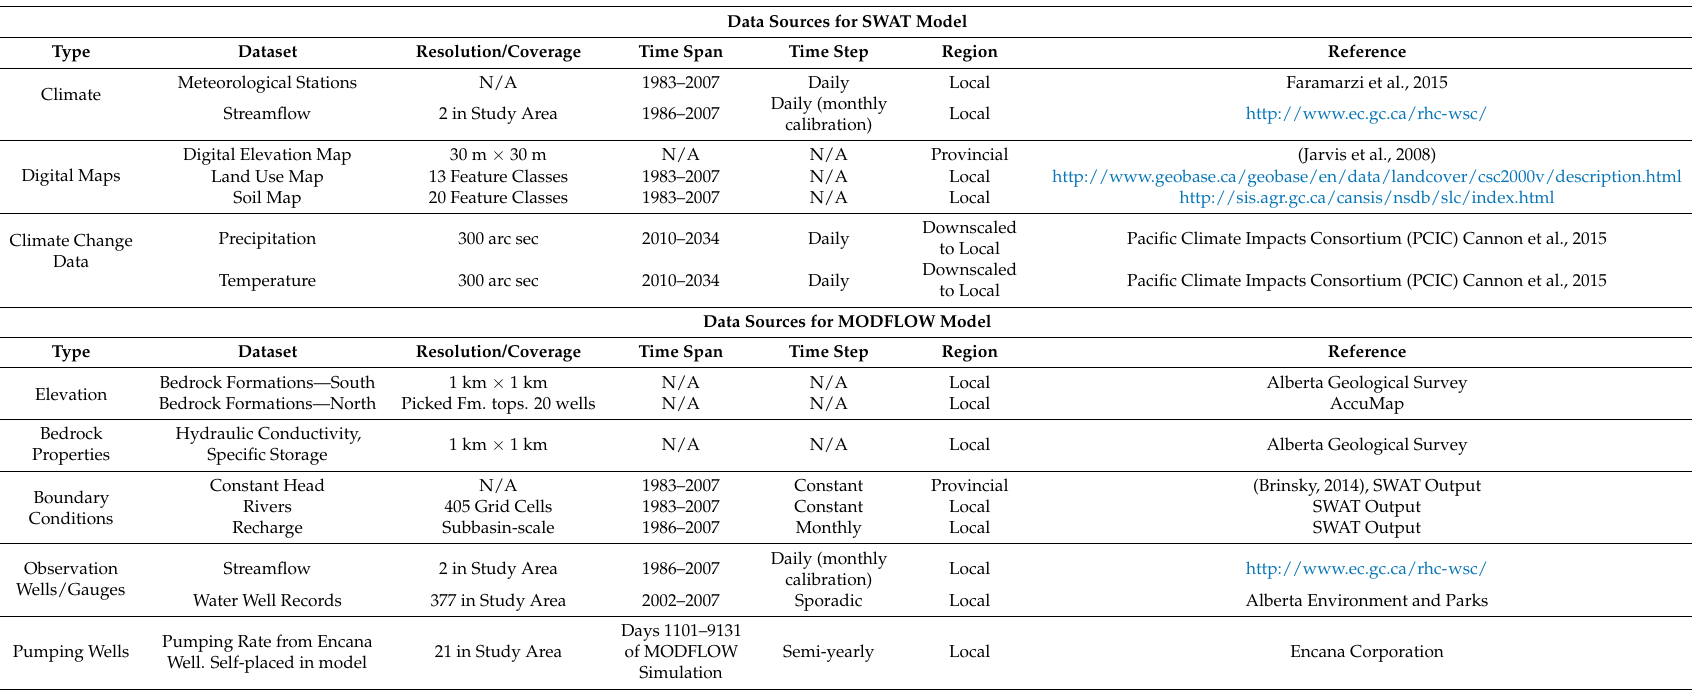
Table A2. Input data required for the MODFLOW model, and their